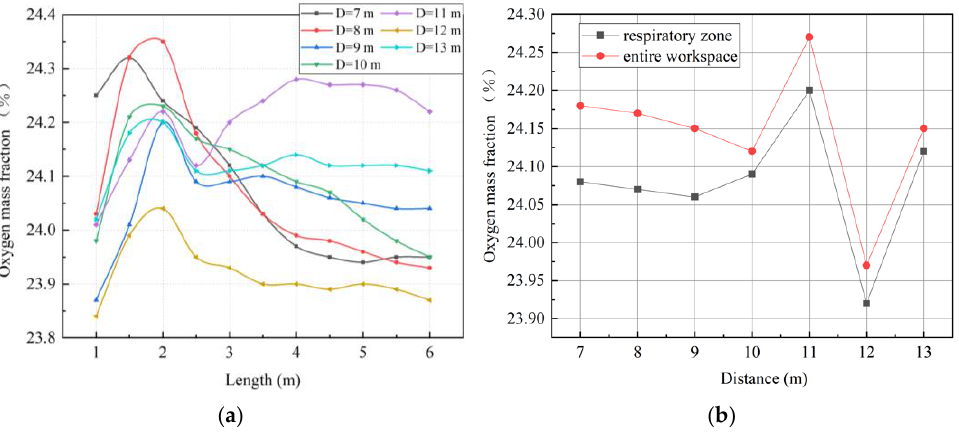
Figure 10. Characteristic diagrams of oxygen mass fraction distributions in the main working area. ( a ) Oxygen mass fractions along the roadway; ( b ) oxygen mass fractions in the respiratory zone and in the entire workspace.